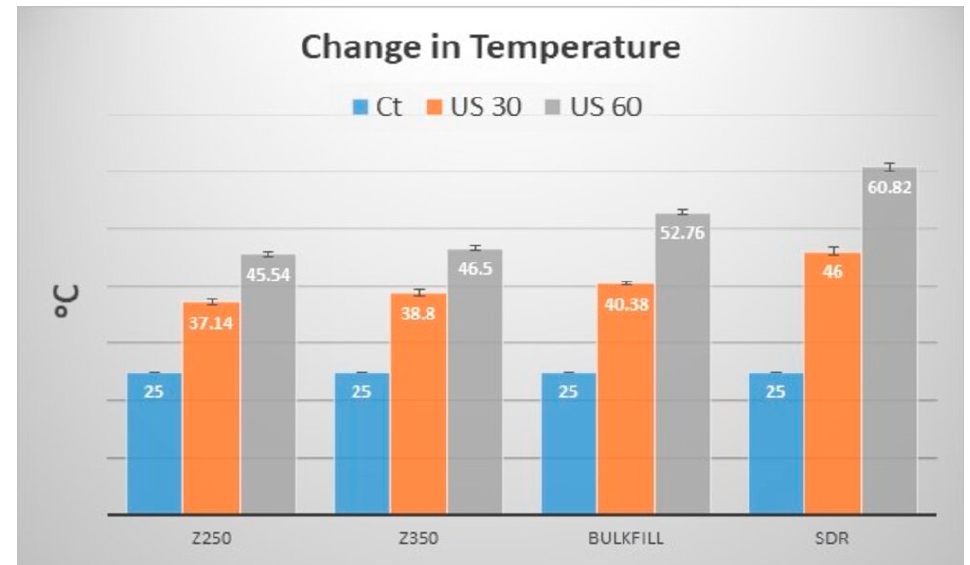
Figure 1. Change in temperature of composites i.e., Filtek Z250, Filtek Z350, Filtek Bulk-fill, and SDR